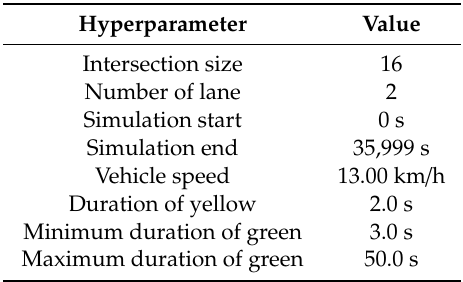
Table 3. Configuration of Road scenario and